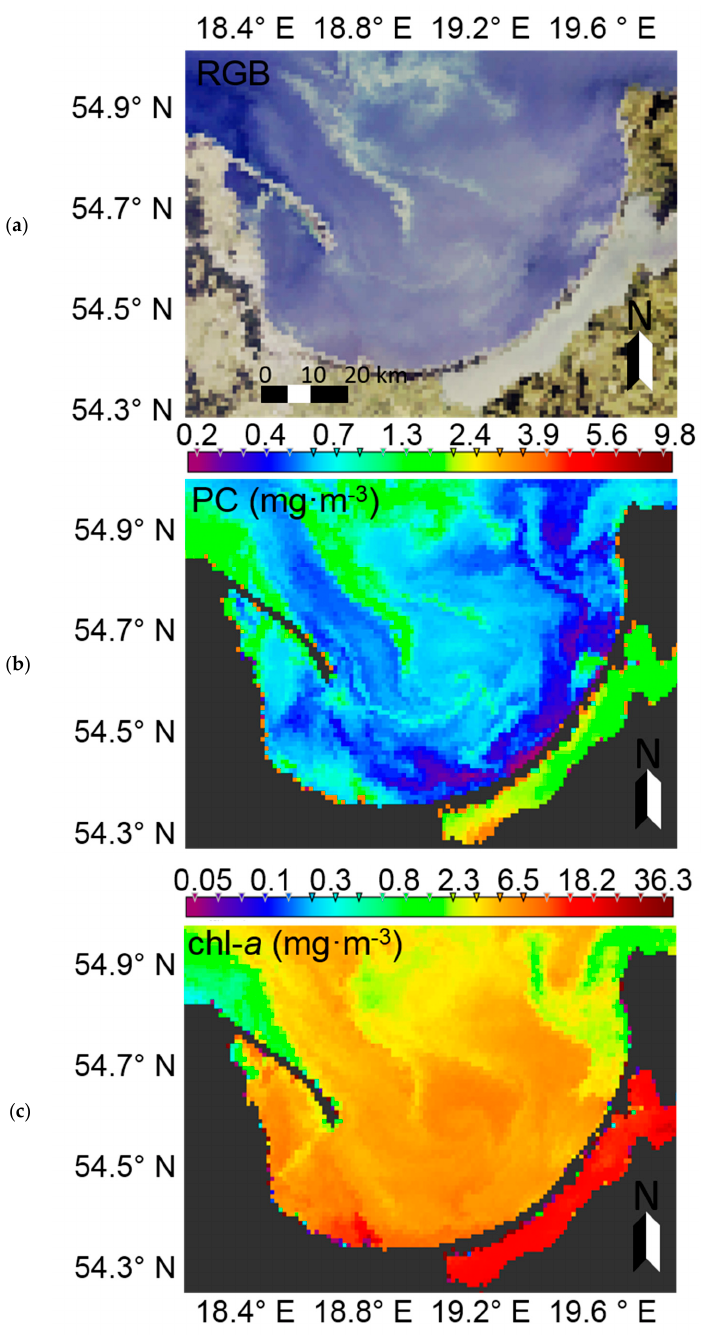
Figure 15. RGB image ( a ), PC ( b ), and chl- a ( c ) retrieved from the EOF model with reflectance spectra acquired from the MERIS radiometer for the Gulf of Gdansk area on 5 July 2010.